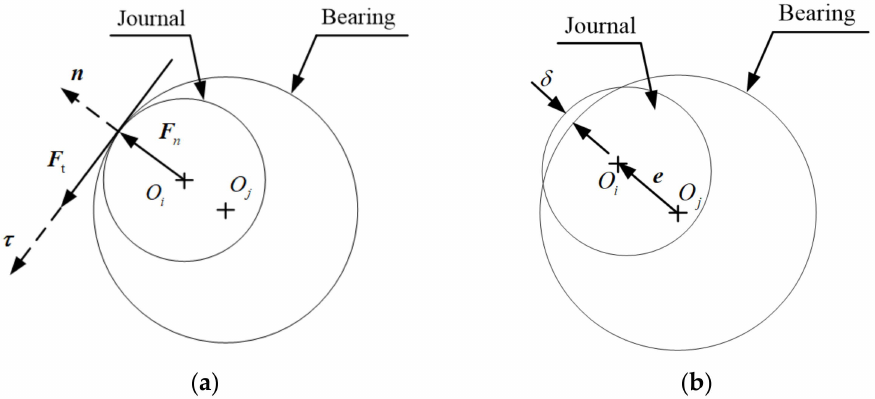
Figure 2. Contact in revolute clearance joint. ( a ) contact forces; ( b ) contact